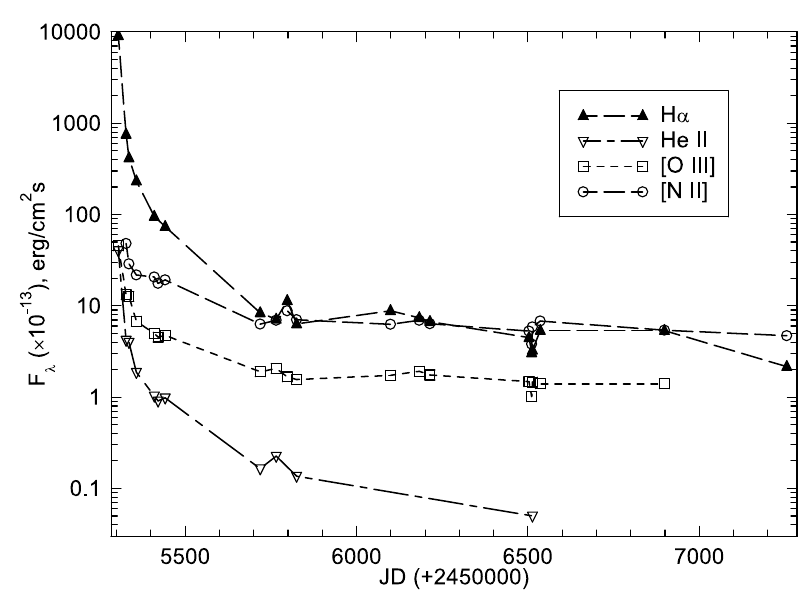
Fig. 3. Fluxes in the H (cid:11) , He II 4686 (cid:23)A, [O III] 5007 (cid:23)A, and [N II] 6584 (cid:23)A emission lines. spectrum (cf. Kolotilov et al.